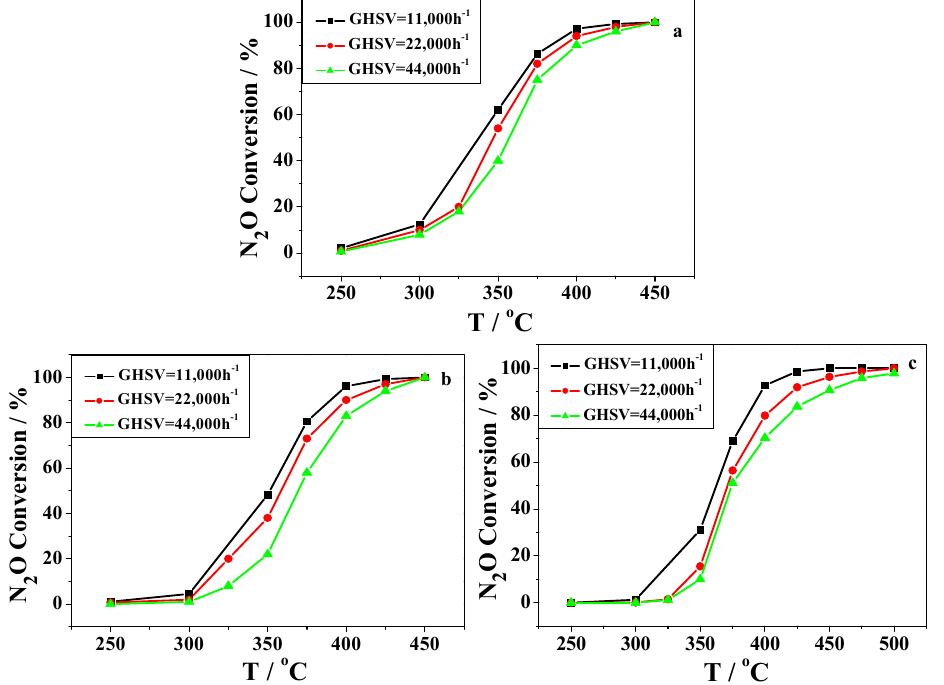
Figure 8. Effect of GHSV on the activity over ( a ) Ru/Al 2 O 3 ‐ H 2 , ( b ) Ru/Al 2 O 3 ‐ NaBH 4 and ( c ) Ru/Al 2 O 3 ‐ air catalysts (reaction conditions: 5000 ppm N 2